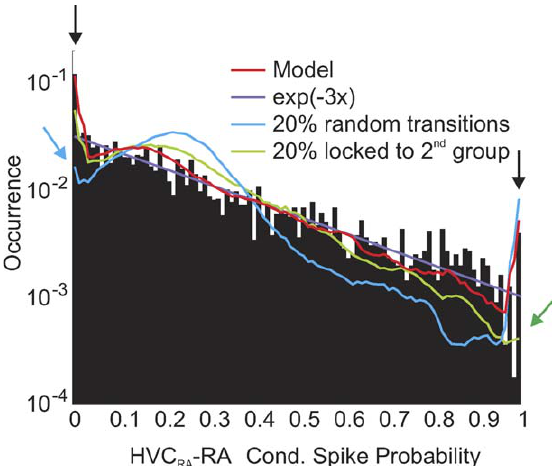
Figure 6. HVC States Evolve Sequentially and Are Formed by Distinct HVC RA Groups Distribution of CSPs in ( n ¼ 46) HVC RA –RA pairs in the interval (cid:2) 60 to 60 ms of HVC RA spikes (black histogram). With the exception of two peaks at CSPs zero and one (black arrows), the distribution is well-approximated by an exponential curve (purple line). Shown are the average CSP functions of 50 simulated HVC RA –RA pairs for three different model assumptions: (1) HVC RA neurons fire with probability p P ¼ 0.8 in a single HVC RA group (red curve); (2) HVC RA neurons fire in two (randomly selected) HVC RA groups with probabilities 0.64 and 0.16 (green curve); and (3) activation of HVC RA groups is sequential in 80% of song-like transitions and in 20% it is random (blue curve). The green and blue arrows indicate inadequacies of model assumptions 2 and 3. p ¼ 6/7, q